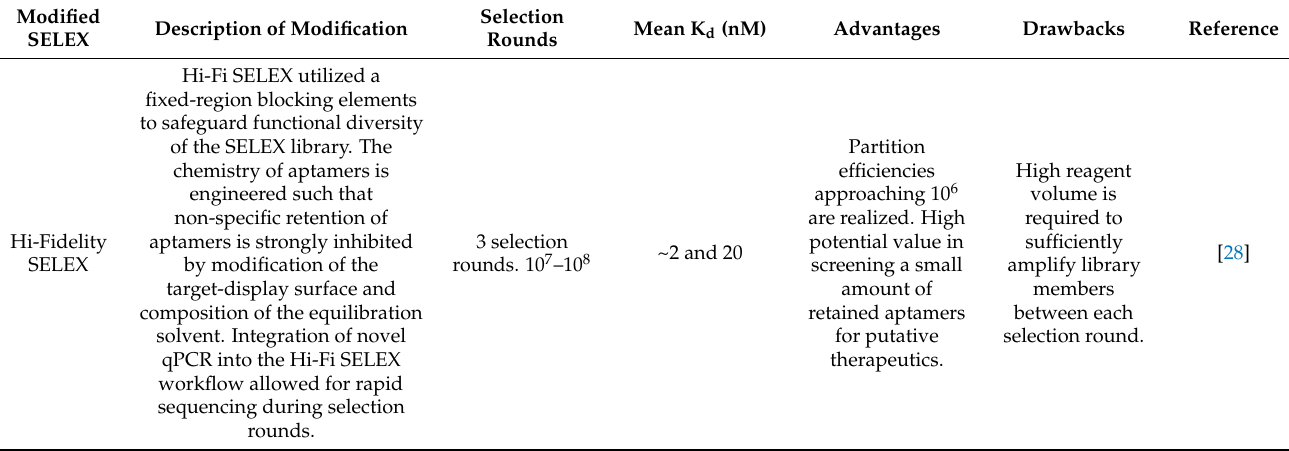
Table 1. A short description of selected modified SELEX stating their key advantages and